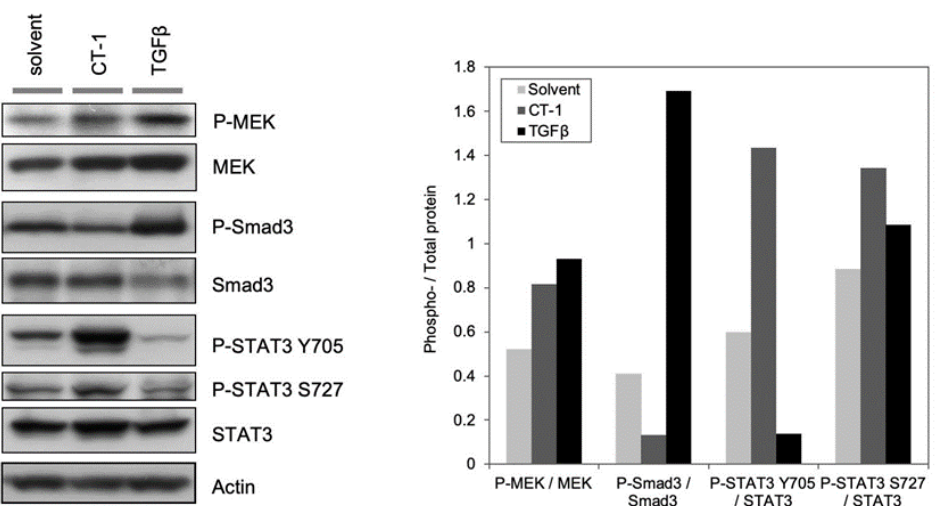
Figure 2. TGFβ stimulates MEK phosphorylation. C2C12 cells were seeded onto cell culture plates at equal density and maintained in TGFβ (1ng/mL), CT-1 (10ng/mL), or solvent. Total protein samples were extracted from the cells and equal amounts of total protein (20 μg) were subjected to Western blotting analysis. The levels of indicated proteins were assessed by a standard immuno-blotting technique with a specific primary antibody. Actin indicates equal amounts of protein loading into each lane (left panel). The experiment was done three times. Quantification of band intensity of the phospho- and corresponding total protein in the left panel were measured using ImageJ, and the ratios of the band intensity of the phospho- to the corresponding total protein band were graphed in each condition (right